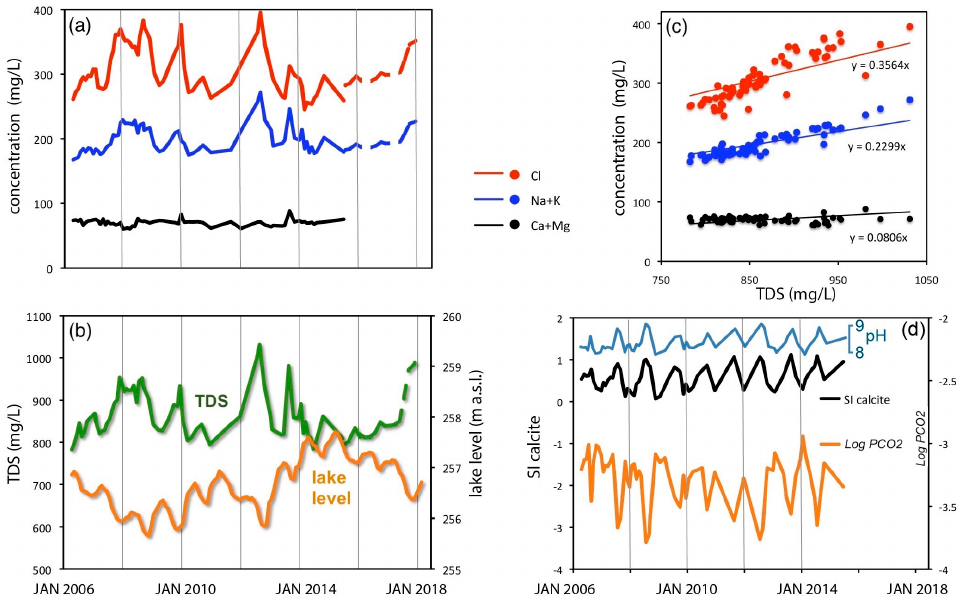
Figure 6. Variations of concentration of Cl, Na + K, Ca + Mg ( a ), TDS and lake level ( b ) over time. Solid lines refer to the new data presented in this work and dashed lines refer to the data of ARPA-Umbria for the period July 2015–January 2018; ( c ) binary plots of Cl, Na + K, Ca + Mg vs TDS; ( d ) variations of pH, log 10 P CO 2 and saturation index of calcite.